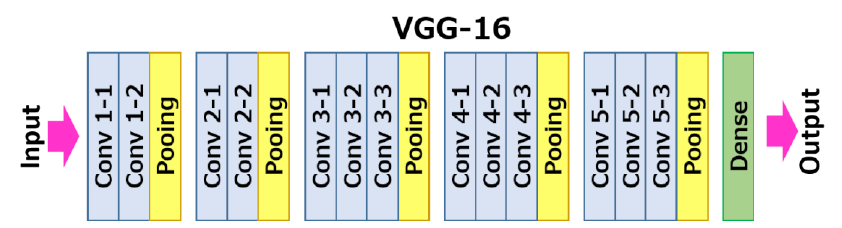
Figure 5. Headerless VGG-16 architecture.